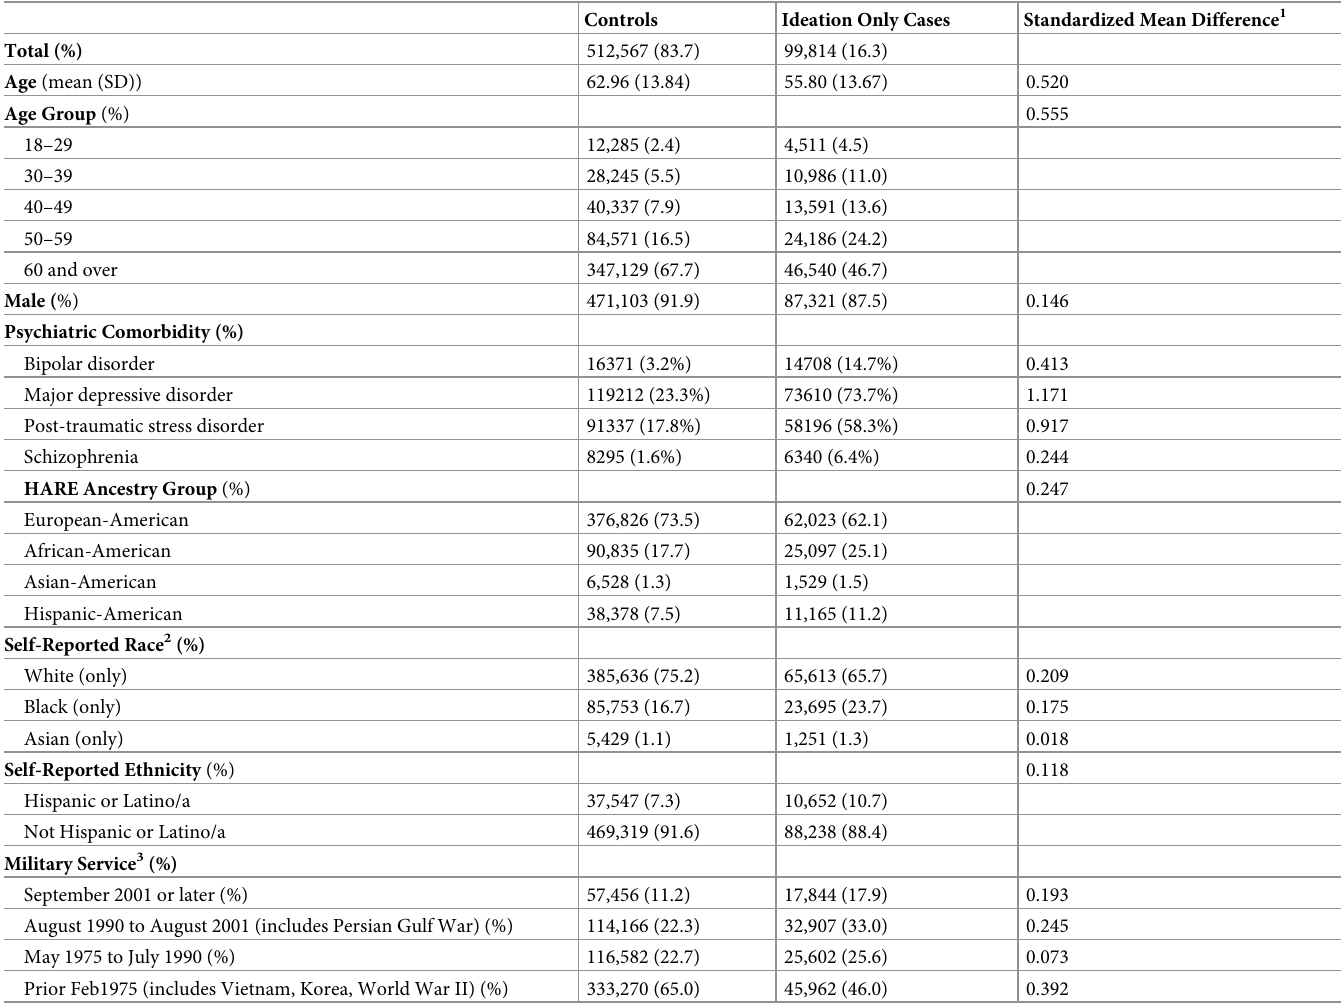
Table 1. Sample characteristics